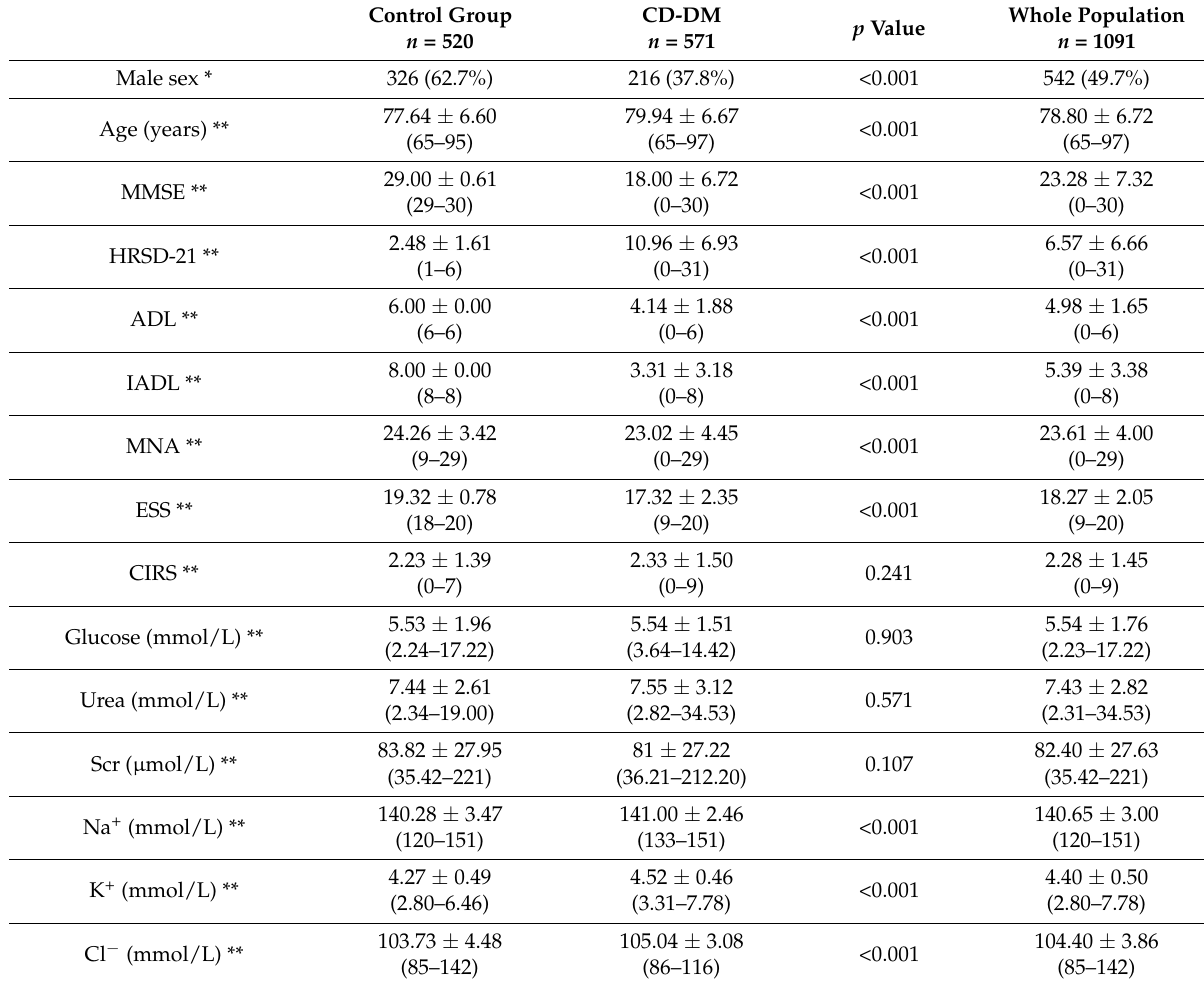
Table 1. Demographic and clinical characteristics of control group and patients with cognitive decline and/or depression mood